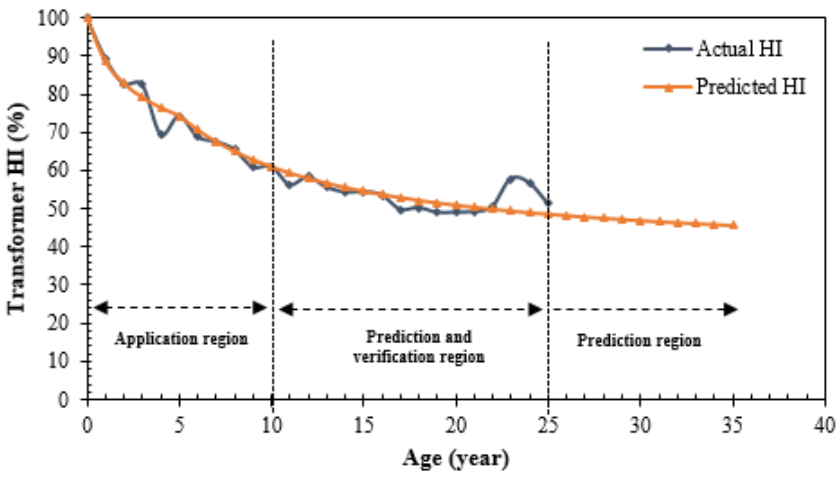
Figure 4 . Comparison between computed and predicted HI. Figure 4. Comparison between computed and predicted HI. Table 4 . Computed and predicted HI.